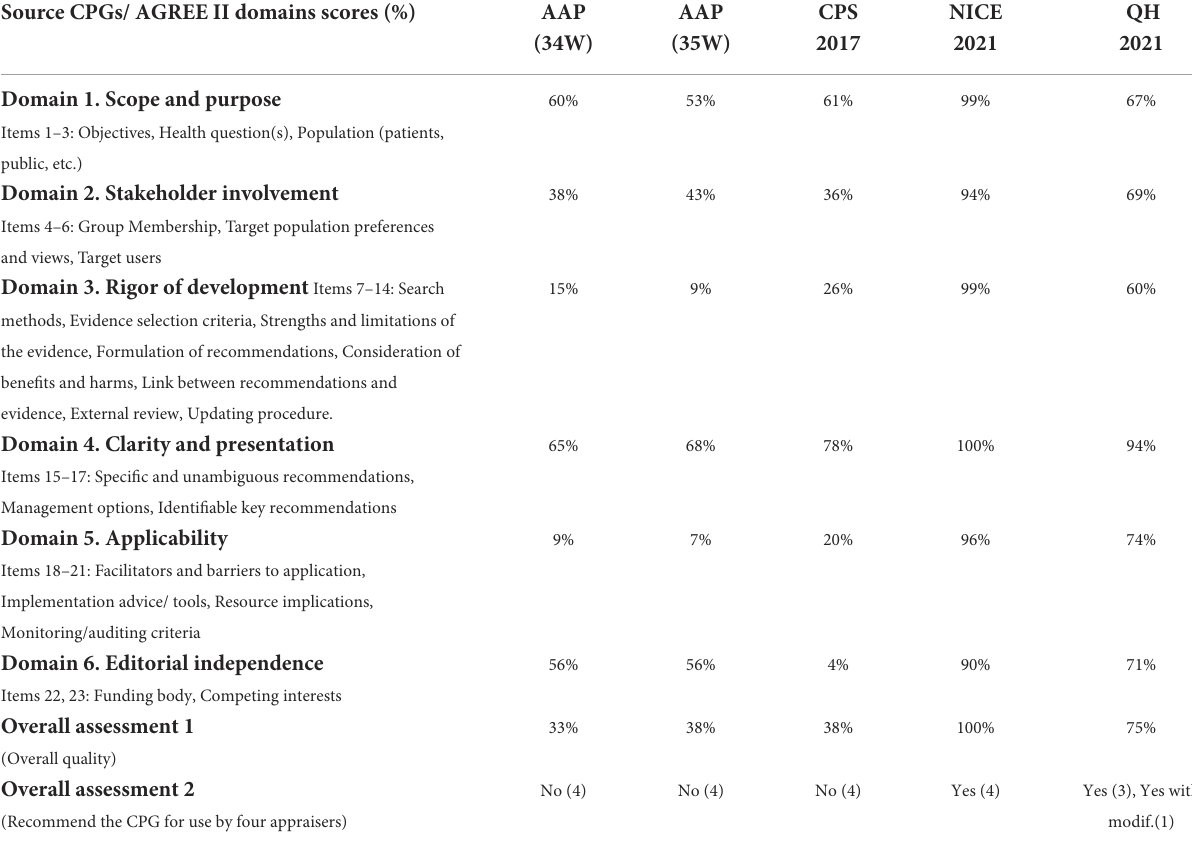
TABLE 2 AGREE II assessment results and domain scores for the five included neonatal sepsis CPGs. Source CPGs/ AGREE II domains scores